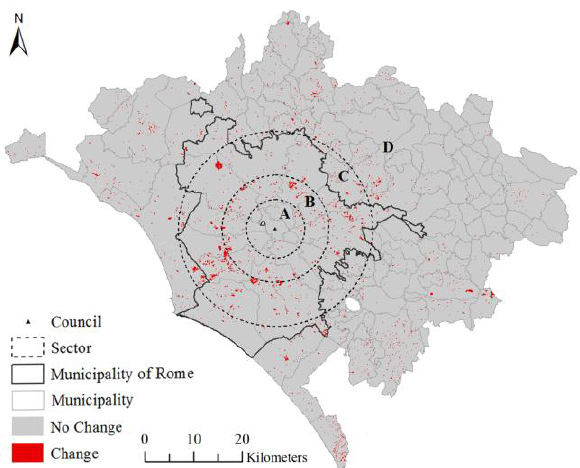
Figure 5. Study area divided by sectors with generic change patches in red. (A) Urban centre; (B) intermediate peri-urban area; (C) peripheral districts of Rome; and (D) other municipalities of the province of